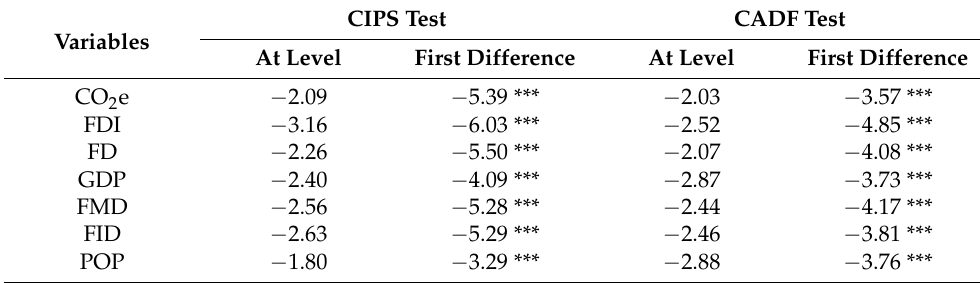
Table 6. CADF and CIPS